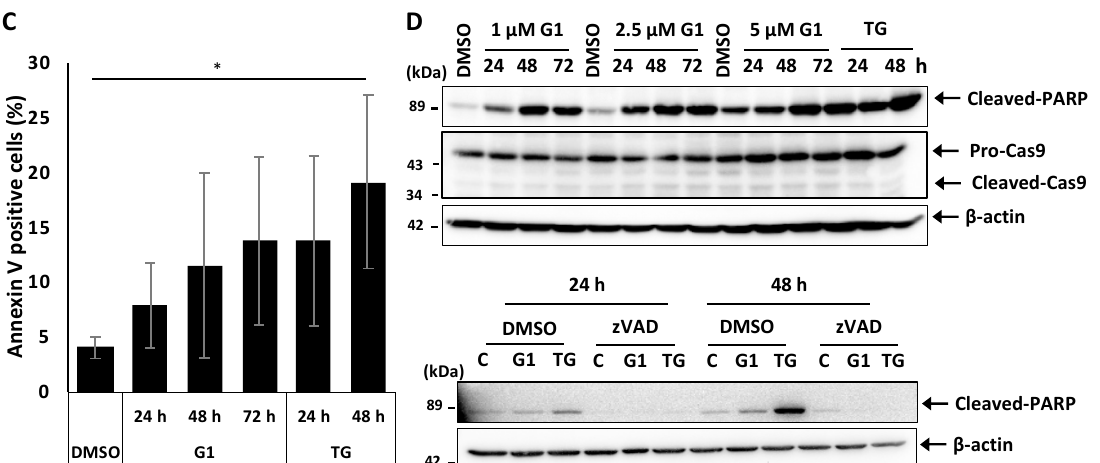
Figure 1. G1 and TG induced cell cycle arrest in G2/M and apoptosis without activating caspase 3 and 9 in MCF-7 cells. MCF-7 cells were treated with 1 µM G1 for 24, 48 and 72 h or with 1 µM TG for 24 and 48 h. ( A ) Cells were stained with propidium iodide (PI), and cell cycle profiles were determined by flow cytometry analysis. The percentage of cells in the different cell cycle phase was calculated. ( B , C ) Cells were double stained with PI and Annexin V. Flow cytometry analysis was performed to determine apoptotic and necrotic cells. Representative dot plots and percentage in each quadrant showed cell death undergoing necrosis (Q1), apoptosis (Q4) or late apoptosis (Q2). * p < 0.05 when compared with cells treated with vehicle. ( D ) MCF-7 cells were treated with 1, 2.5 and 5 µM G1 for 24, 48 and 72 h, or with 1 µM TG for 24 and 48 h, or pretreated with 20 µM pan caspases inhibitor zVAD-fmk for 1 h and then treated with 1 µM G1 or TG for 24 and 48 h. Total protein lysates were subjected to Western blotting using appropriate antibodies as indicated.